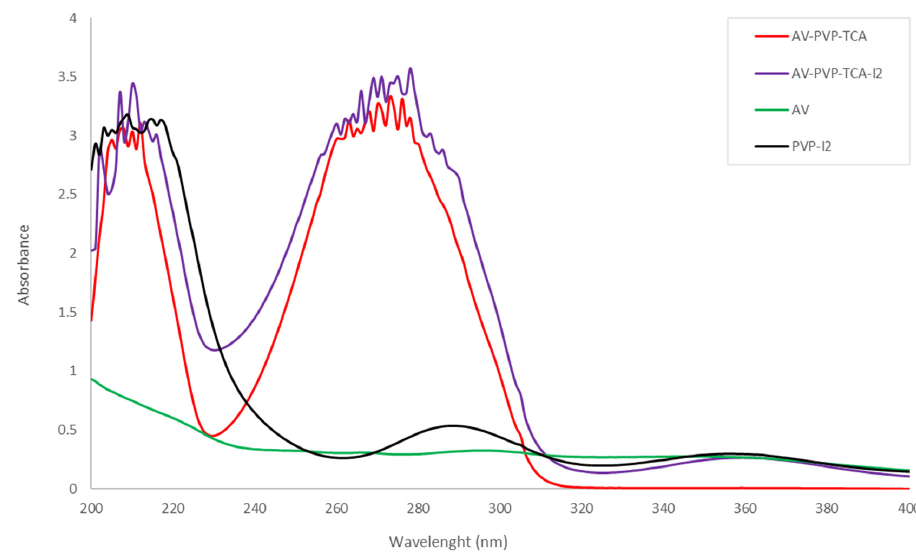
Figure 6. UV-vis analysis of AV-PVP-TCA, AV-PVP-TCA-I 2 , AV and PVP-I 2 (200–400 nm). (AV-PVP-TCA: red; AV-PVP-TCA-I 2 : purple; AV: green; PVP- I 2 : black).